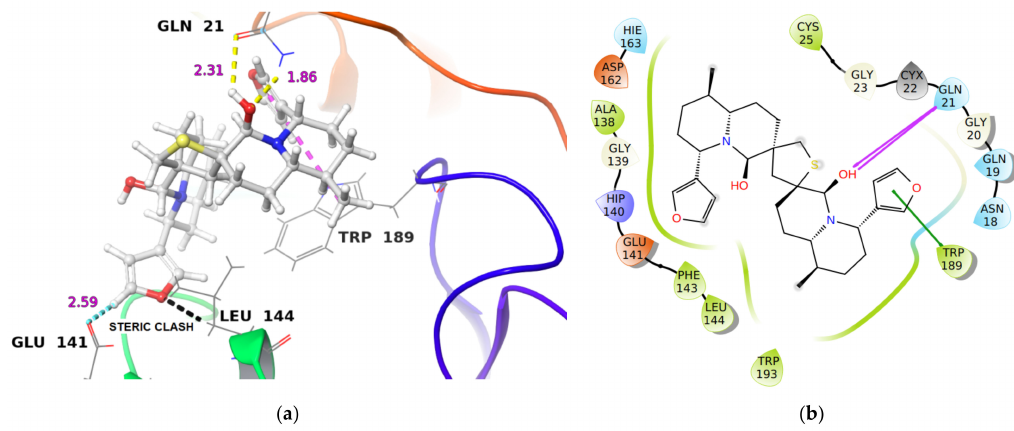
Figure 4. ( a ) 3-D representation of DTBN docked to Cathepsin L. H-bond interactions are displayed with yellow dotted lines, C-H ... O hydrogen bonds are displayed with cyan blue dotted lines, π ... π stacking interaction is displayed with pink dotted line, steric clash is displayed with black dotted line. ( b ) 2-D Ligand interaction diagram of DTBN docked to Cathepsin L.